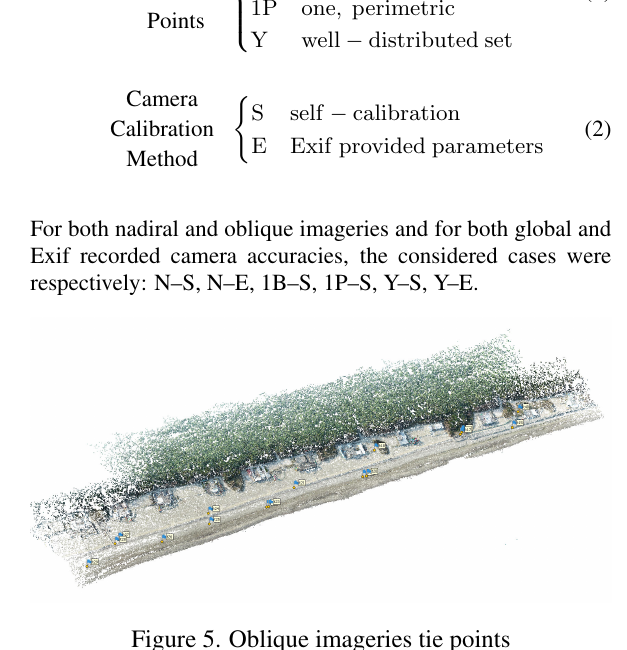
Figure 5. Oblique imageries tie